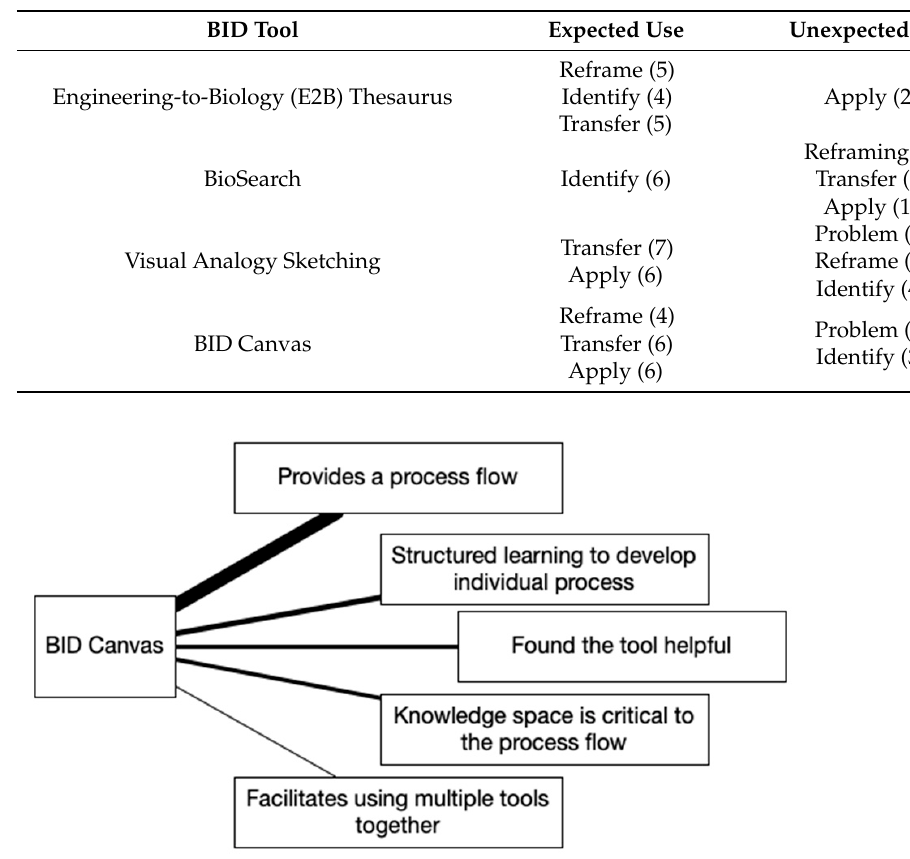
Table 4. Expected and Unexpected BID Tool Use.